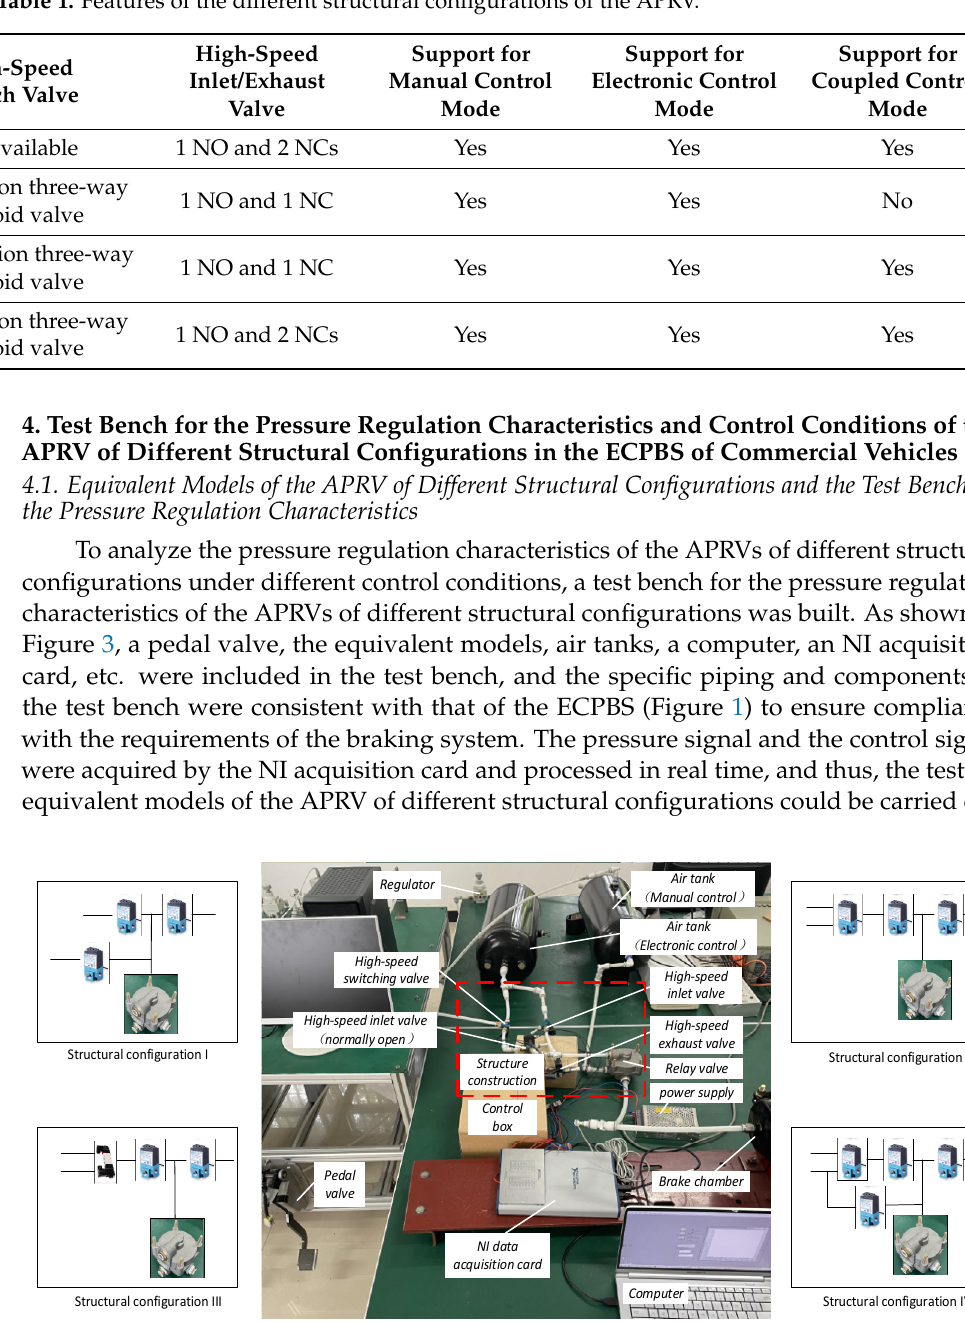
Table 1. Features of the different structural configurations of the APRV.